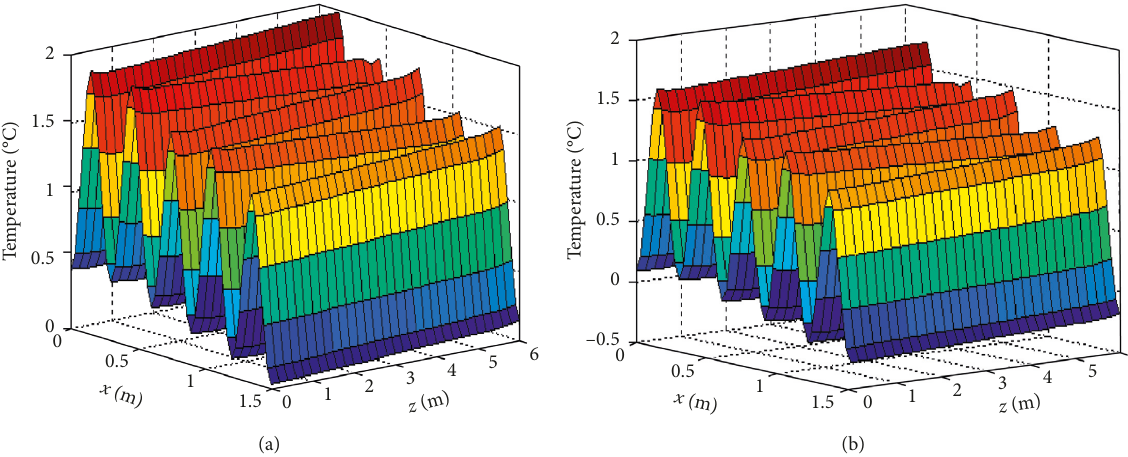
Figure 7: Surface temperature distribution of HSMP: (a) with insulating the bottom; (b) without insulating the